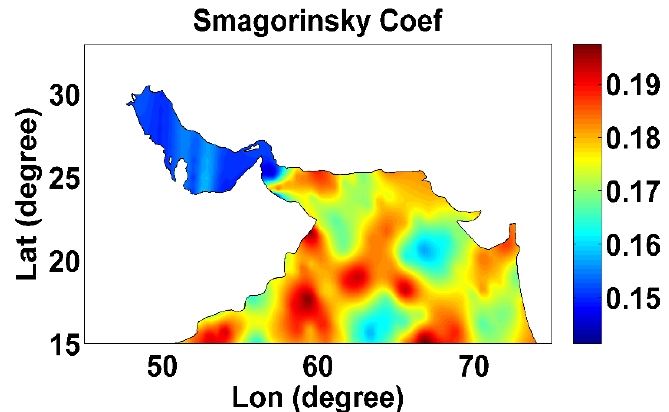
Figure 13. Optimum Smagorinsky coefficient in the study area.